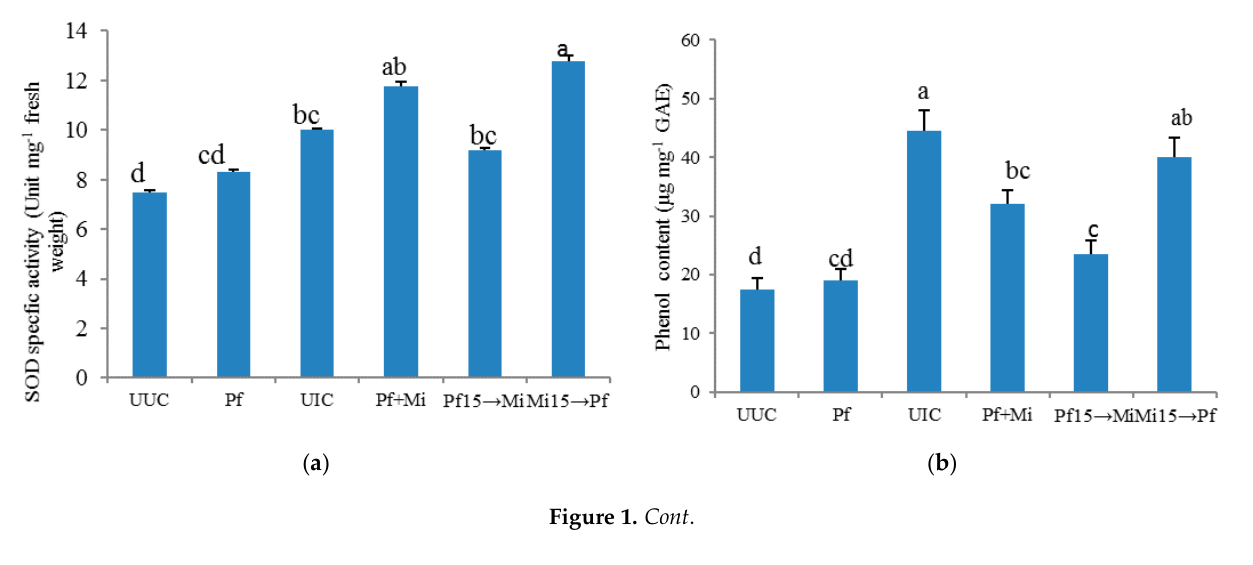
Each value is the mean of five replicates; Means in each column followed by the same letter are not significantly different according to Duncan’s Multiple Range Test (DMRT) at p ≤ 0.05. → Indicates the sequence of inoculation of M. incognita (Mi)/ P. fluorescens (Pf) 15 days prior. + Indicates simultaneous inoculation. UUC: Untreated Uninoculated Control. UIC: Untreated inoculated Control.